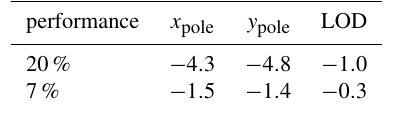
Table 1. WRMS improvement [%] for the Earth Rotation Parame- ters for site “AE” with assumed performances of 20% and